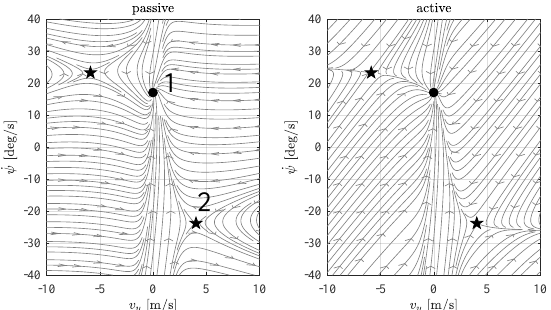
Figure 7. Phase portrait of vehicle dynamics: yaw rate ˙ ψ and vehicle lateral speed v y . Passive ( left ) and active ( right ) vehicles. Equilibria are marked with different markers according to the nature of the node: • for stable nodes, (cid:63) for saddle nodes, and ◦ for unstable